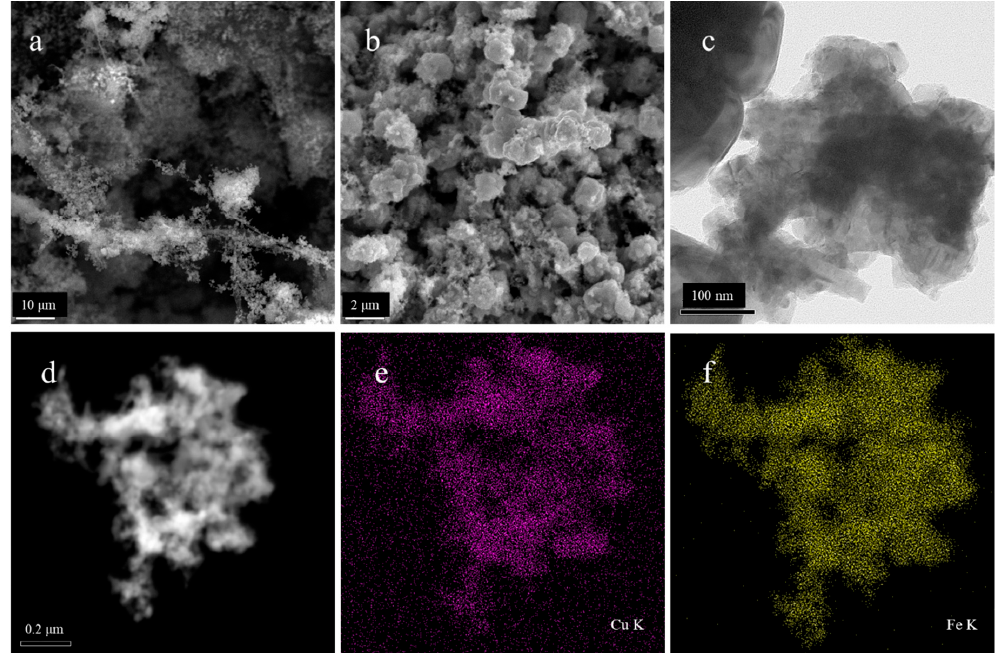
Figure 1. SEM images of ( a ) HKUST-1/Fe 3 O 4 /cellulose microfibril (CMF) composites and ( b ) carbon-doped CuO/Fe 3 O 4 composite catalysts after calcination; TEM images of ( c ) carbon-doped CuO/Fe 3 O 4 composite catalysts; ( d – f ) energy-dispersive X-ray spectroscopy (EDX) mapping of carbon-doped CuO/Fe 3 O 4 composite catalysts.